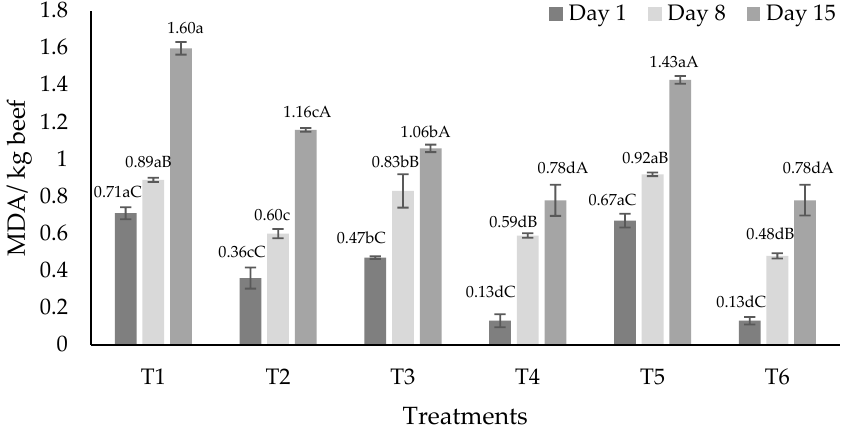
Figure 2. Lipid oxidation (MDA/kg beef, mean) over time in beef hamburgers added to rosemary ( Rosmarinus officinalis ) and garlic ( Allium sativum ) essential oils and chipotle pepper ( Capsicum annum ). T1 = control, T2 = 1% garlic essential oil ( w / w ), T3 = 1% rosemary essential oil ( w / w ), T4 = 0.5% chipotle pepper oleoresin ( w / w ), T5 = 1% garlic essential oil + 0.5% chipotle pepper oleoresin ( w / w ) and T6 = 1% rosemary essential oil + 0.5% chipotle pepper oleoresin ( w / w ). a,b,c = different lowercase literals indicate significant difference ( p < 0.05) between treatments. A,B,C = different capitalized literals indicate significant difference ( p < 0.05) through time.